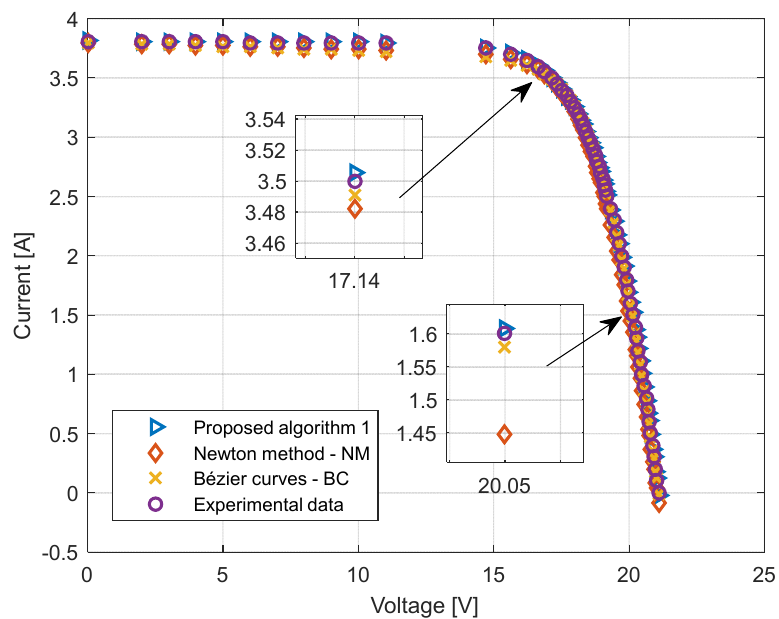
Figure 7. Current-voltage characteristics of the Solarex MSX–60 PV module.